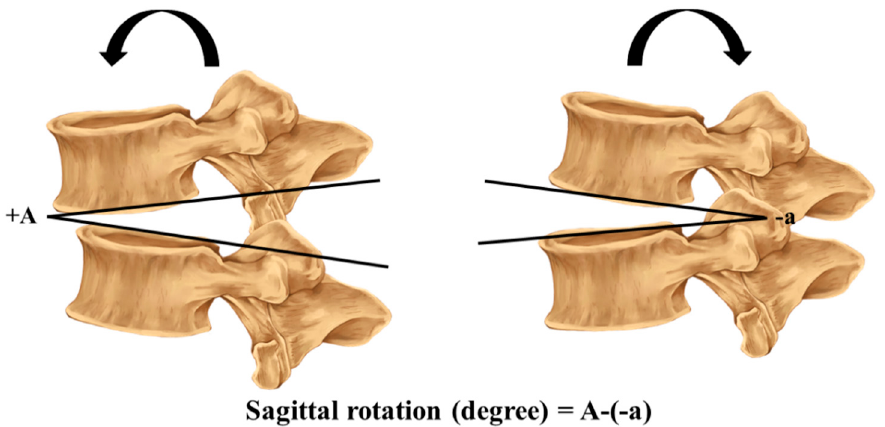
Figure 1. Sagittal rotation: a baseline is drawn passing the anterior and posterior endplate of the upper and lower vertebrae where the difference between the flexion and extension radiograph is measured and calculated.